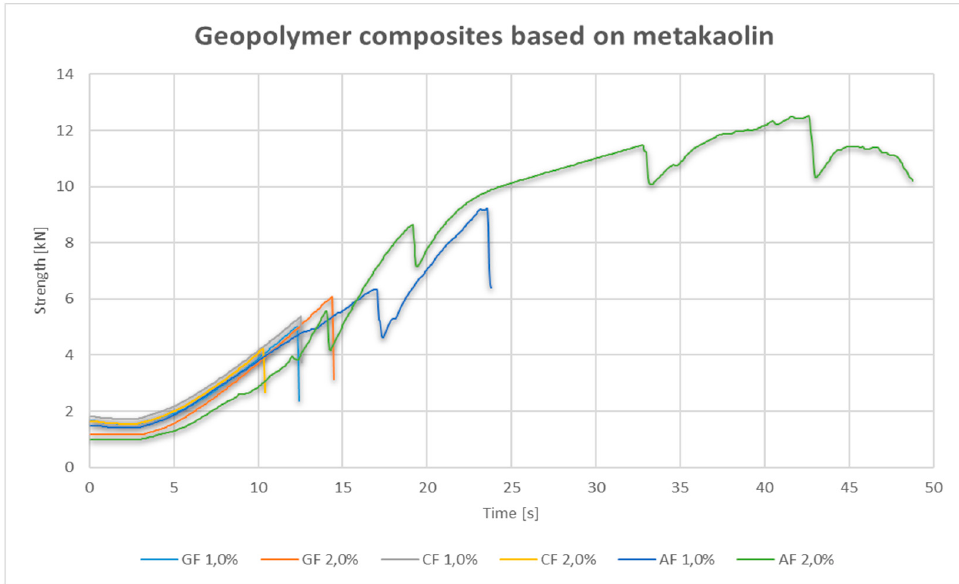
Figure 4. Strength–time graph for the bend test for metakaolin-based composites.